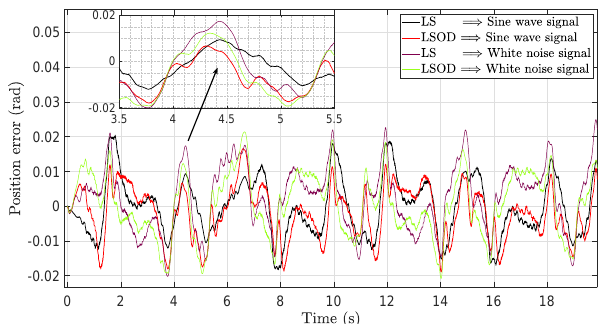
Figure 6. Position errors produced by control law (60) with parameter estimates β ∗